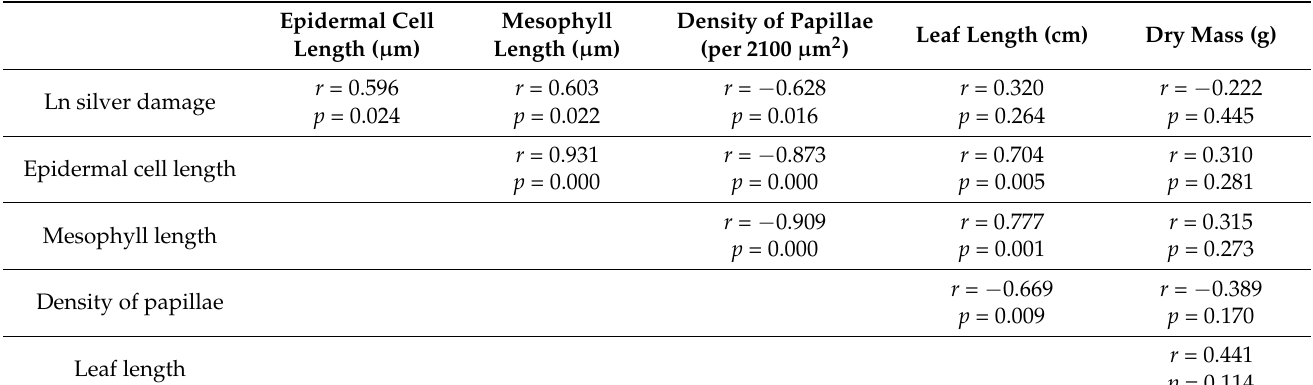
Table 1. Pearson correlations ( N = 14) between ln-thrips silver damage (mm 2 ) and epidermal cell length ( µ m), mesophyll length ( µ m), density of papillae (per 2100 µ m 2 ), leaf length (cm), and dry mass (g) in Gladiolus varieties ( N = 14). Data represent means of three to five replicates. Data in bold show the significance level at p ≤ 0.05.